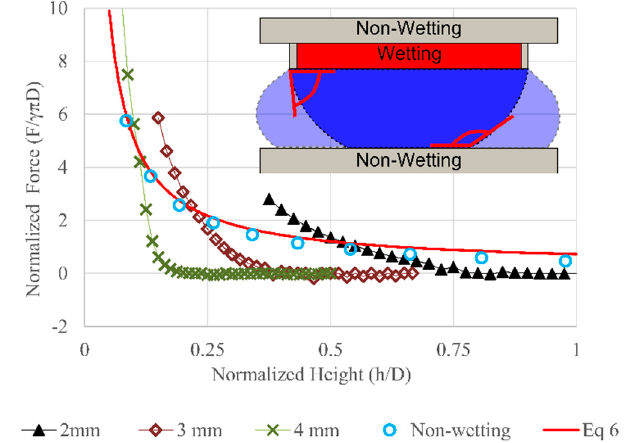
Figure 7. Normalized force vs. normalized height with type 3 wetting. Results are compared to predictions from Equation (6), the simulation result from Type 1 (symmetric non-wetting, contact angle: 165°, droplet volume 50 µL). The inset shows the wetting region and geometrical constrain on the top plate.